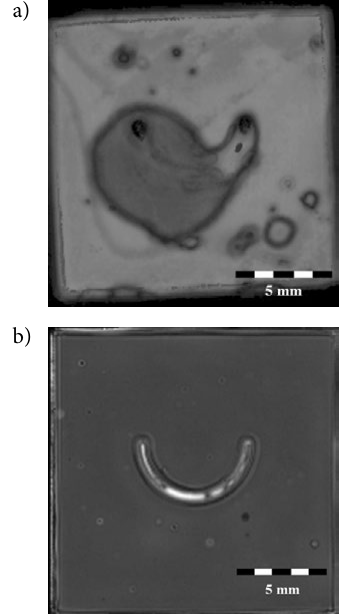
Fig. 9. On the SAM picture of the 21 th lamination method the delaminations are caused by the inadequate pressure (a); the 26 th lamination method laminated the layers permanently together (b) ( source : own